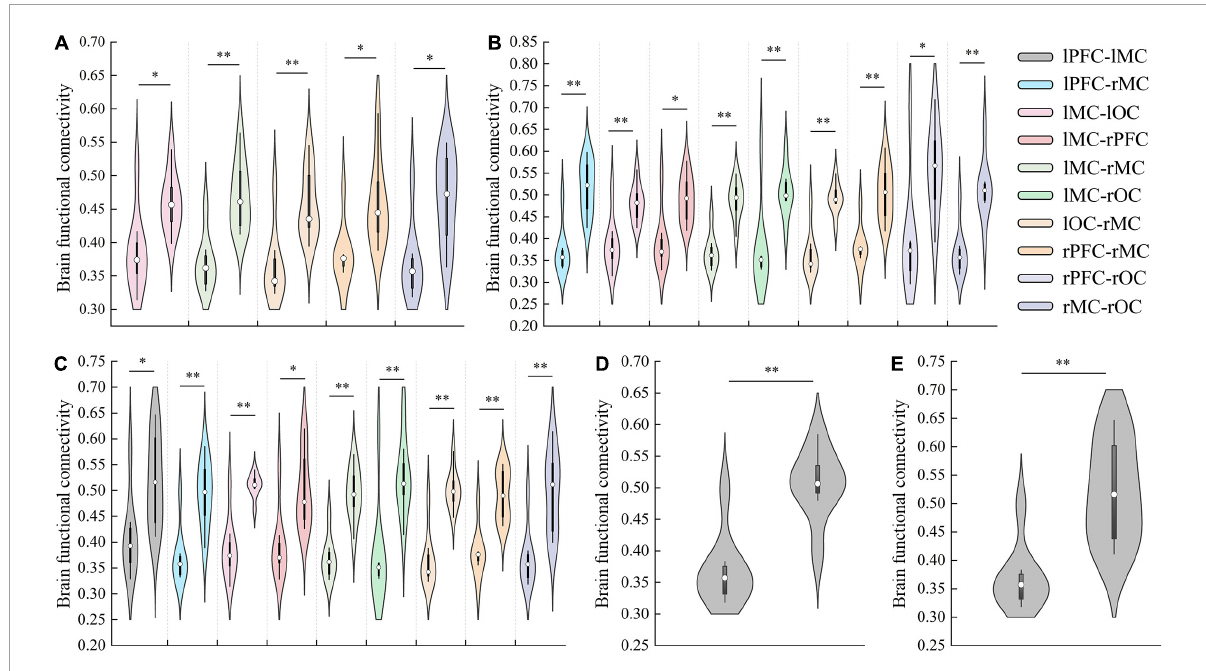
FIGURE4 The results of significant changes of FC value between resting and initial stage (A) , resting and intermediate stage (B) , resting and sprint stage (C) , initial and intermediate stage (D) , initial and sprint stage (E) . ∗ p < 0.05, ∗∗ p <